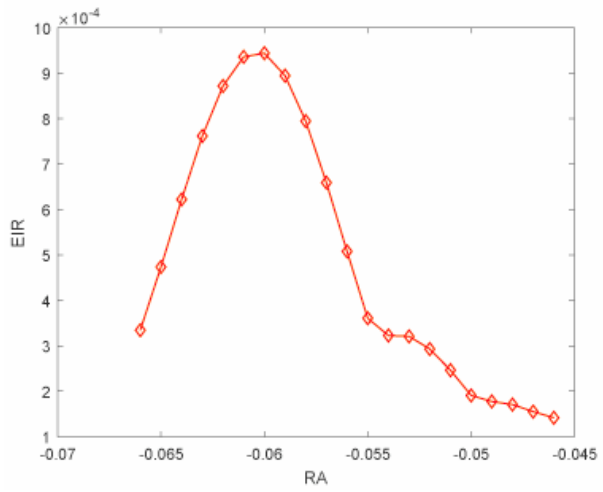
Figure 9. Energy integration ratio (EIR) versus the RA.